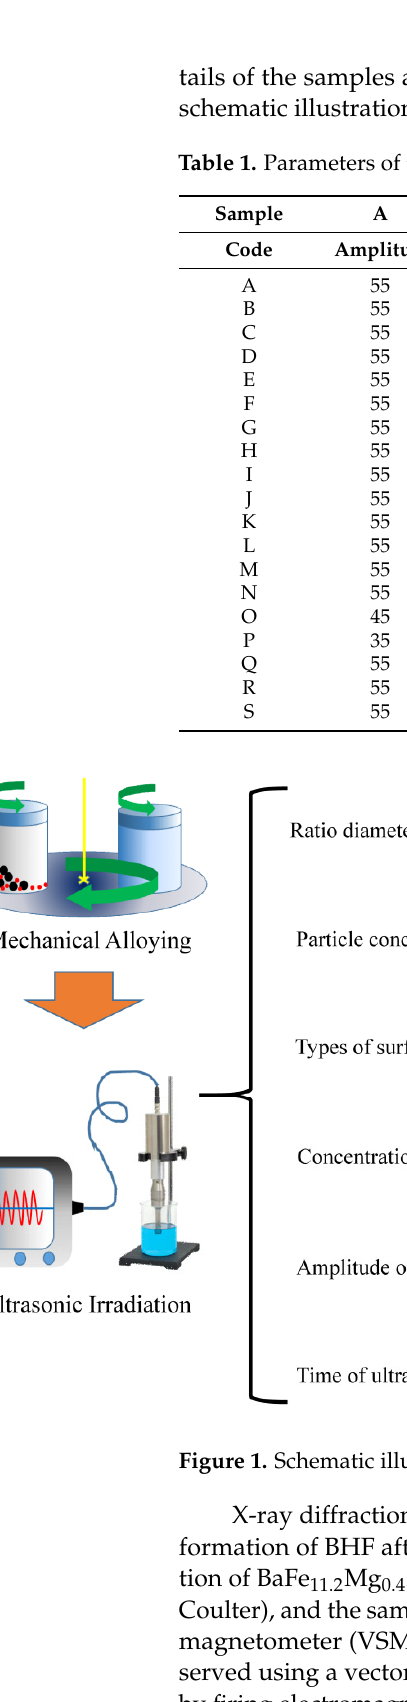
Figure 2. X-ray diffraction pattern of BHF and Mg-Al doped BHF.